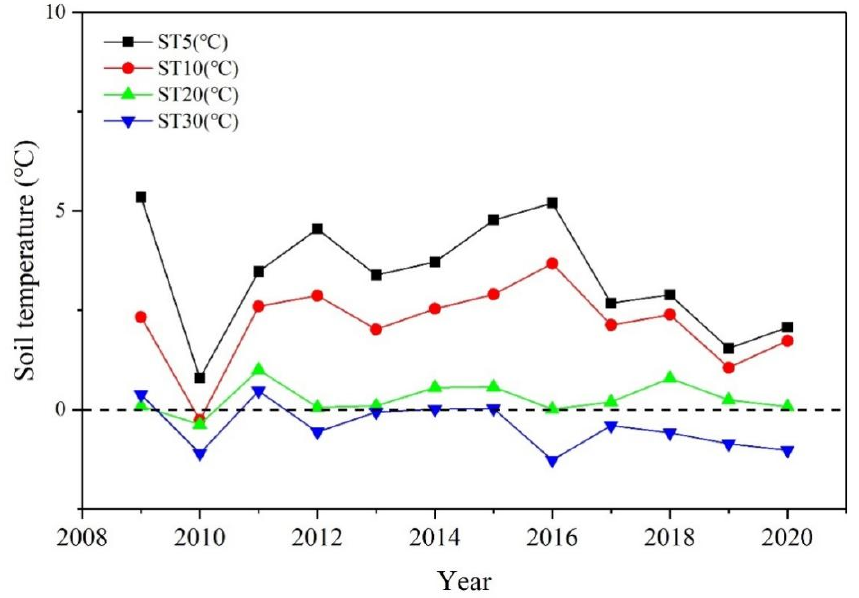
Figure 3. Daily averages of soil temperatures at depths of 5 cm (ST5), 10 cm (ST10), 20 cm (ST20) and 30 cm (ST30) at the end of the spring thaw period from 2009 to 2020.